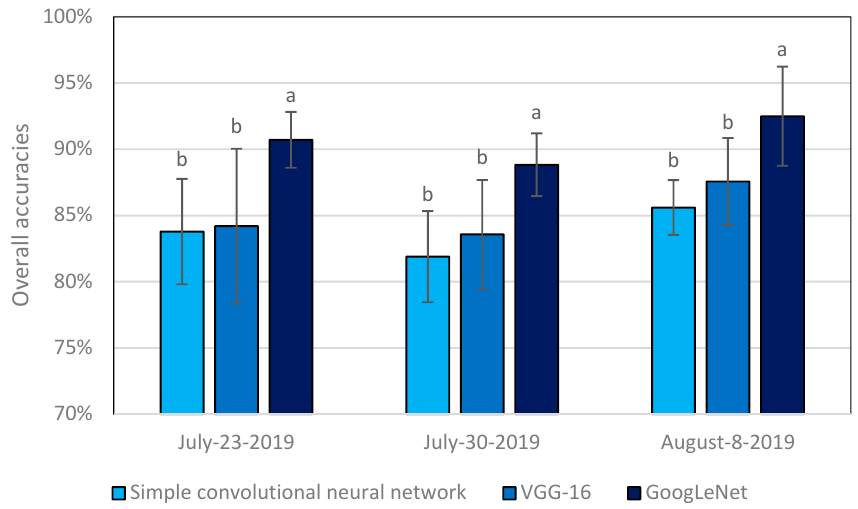
Figure 17. Accuracy comparisons of three deep learning algorithms (simple convolutional neural network, VGG-16, and GoogLeNet) on individual date datasets. Whiskers on bars represent two standard deviations calculated from 10 replicates. Bars with different letters are significantly different by Tukey’s test at 0.05 significance level.